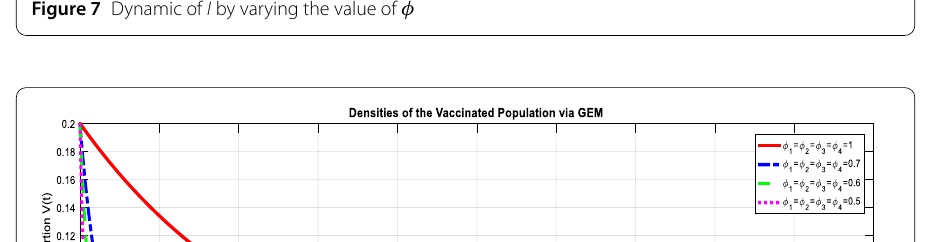
Figure 7 Dynamic of I by varying the value of φ